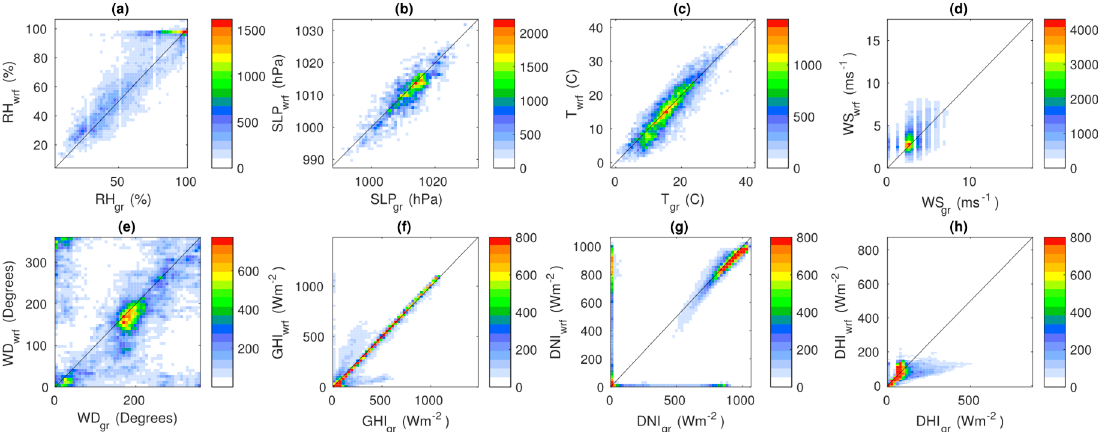
Figure 12. Density (shaded) scatterplots of measured and modelled surface (( a ) RH, ( b ) SLP, ( c ) T, ( d ) WS, ( e ) and WD) and solar irradiance (( f ) GHI, ( g ) DNI, and ( h ) DHI) variables using WRF-Solar at 15 km grid spacing.